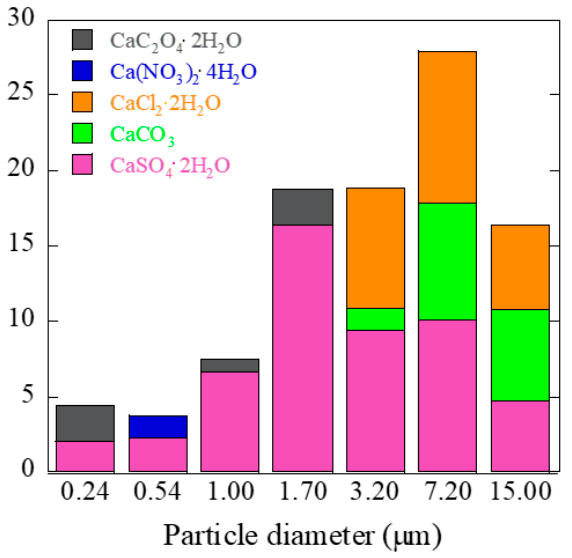
Figure 5. Speciation of Ca in aerosols determined by XANES analyses.